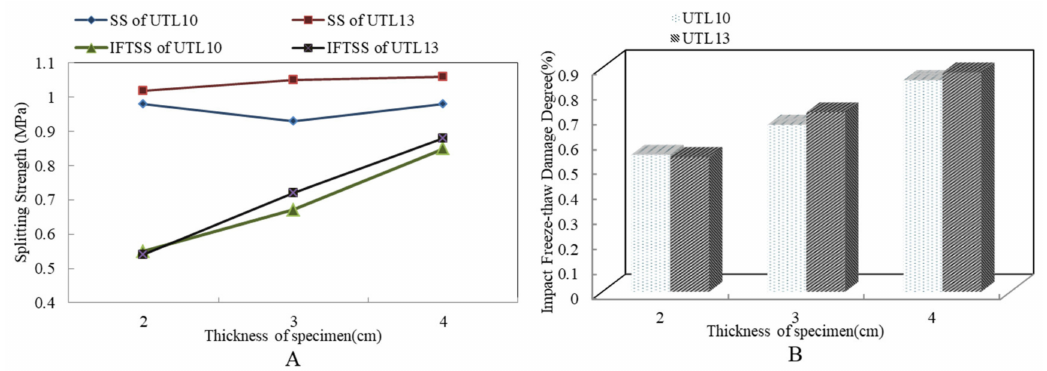
Figure 4. Results of impact freeze thaw split test with di ff erent mixture thicknesses: ( A ) SS and IFTSS; ( B )